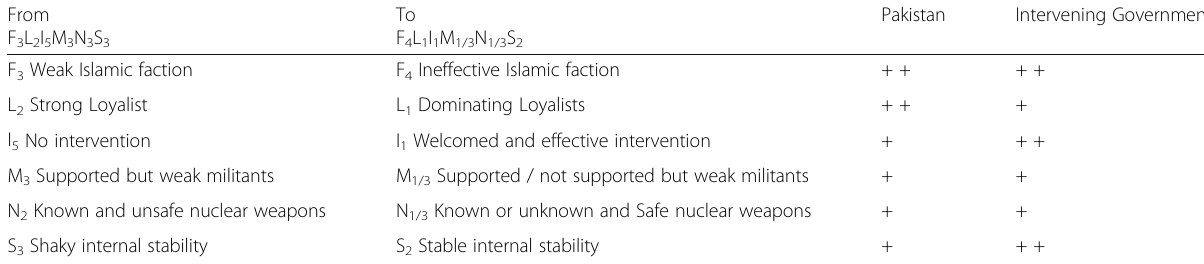
Table 6 Using congruence analysis to understand party preference to change from current world to preferred world From F 3 L 2 I 5 M 3 N 3 S 3